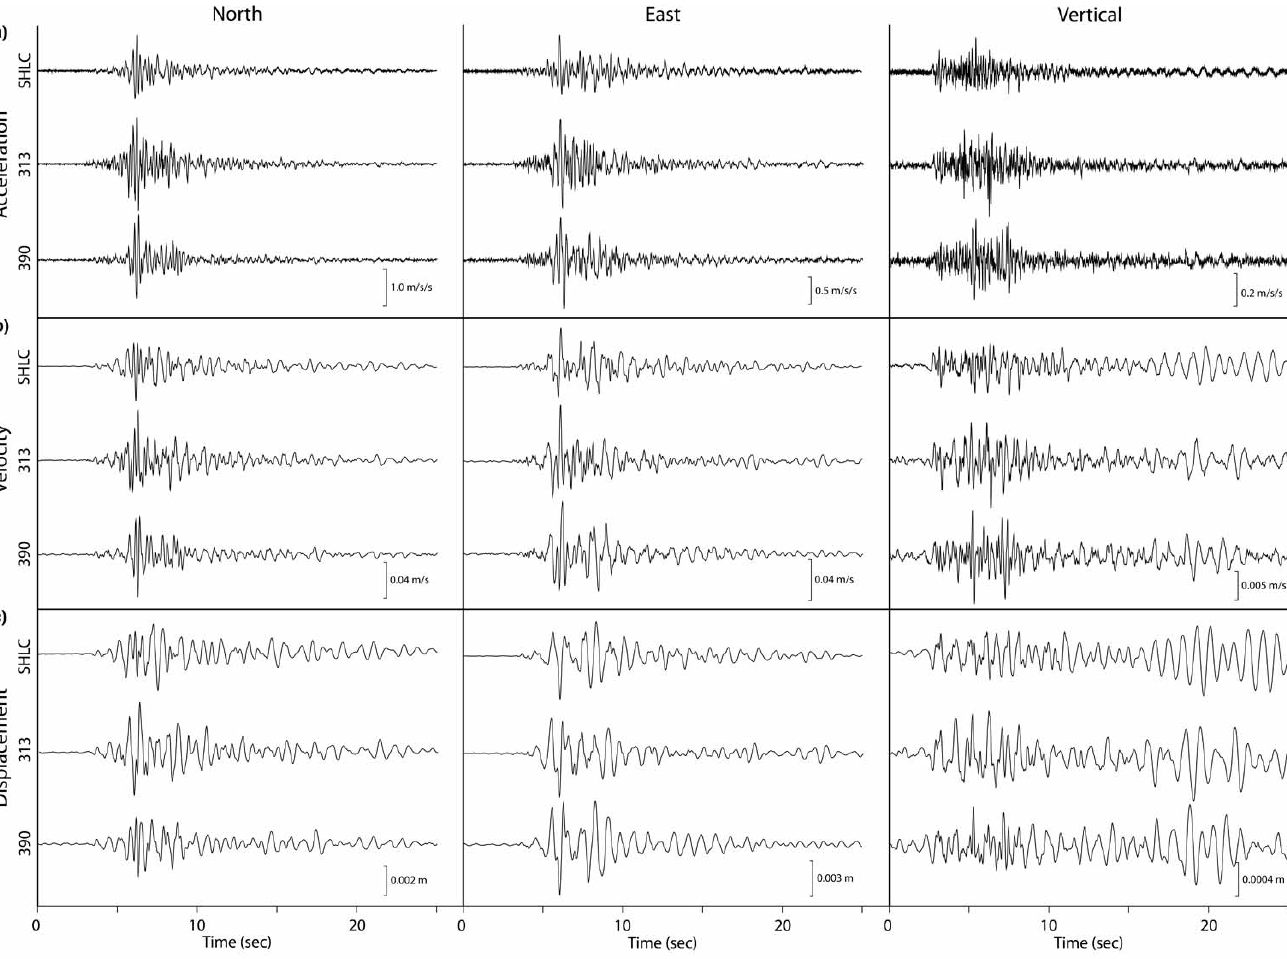
Figure 5. (a) Acceleration, (b) velocity, and (c) displacement time series for the North-South, East-West, and vertical components for stations SHLC, 313, and 390. Note that the vertical component ground motions are approximately one order of magnitude smaller than the horizontal ground